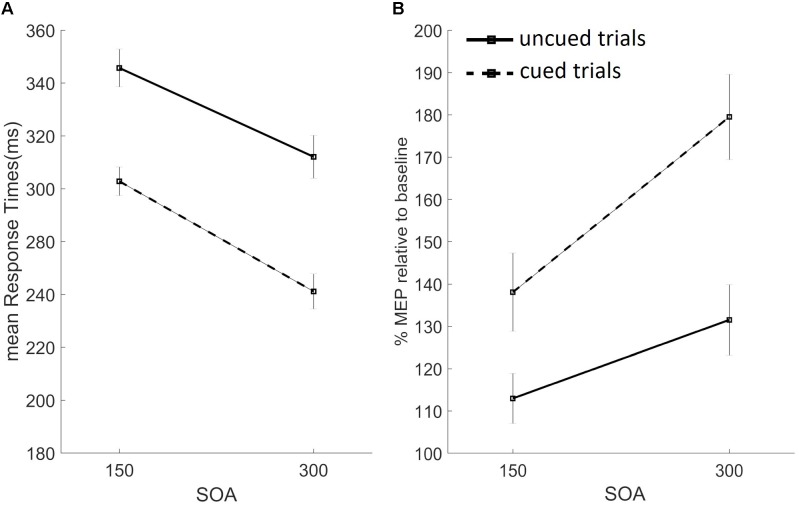
Results from the uncued (black filled lines) and cued (black dashed lines) trials, for the short (150 ms) and long (300 ms) SOA conditions are presented. Data from the pure and mixed blocks were averaged. (A) Mean response times in milliseconds. (B) Percentage of mean MEP amplitudes at target onset, relative to baseline, for the FDI muscle. Error bars represent the standard error.